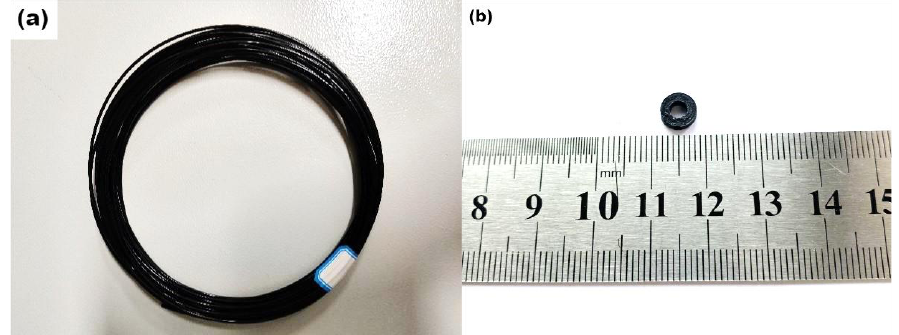
Figure 1. ( a ) CB − CIP/PLA composite filament; ( b ) absorption test coaxial ring. Figure 1. ( a ) CB-CIP/PLA composite filament; ( b ) absorption test coaxial